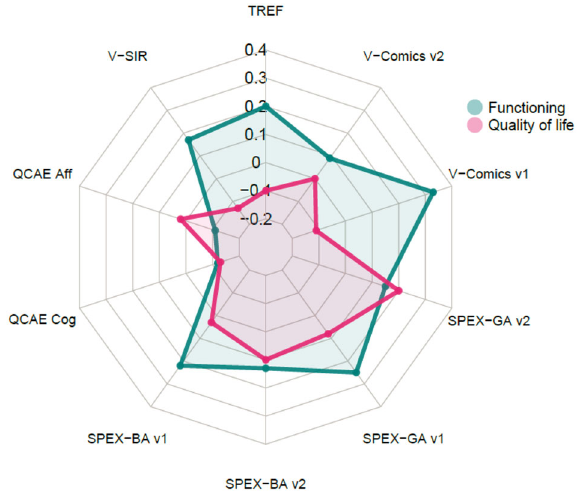
Fig. 2 ß standardized coef fi cients of simple regressions of functioning (PSP) and quality of life (S-QoL) at follow-up on various social cognition measures at inclusion. Legends: please see Fig.